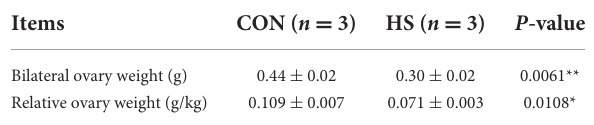
TABLE 2 Relative ovary weight for female rabbits ( n = 3 per group), as affected by HS.